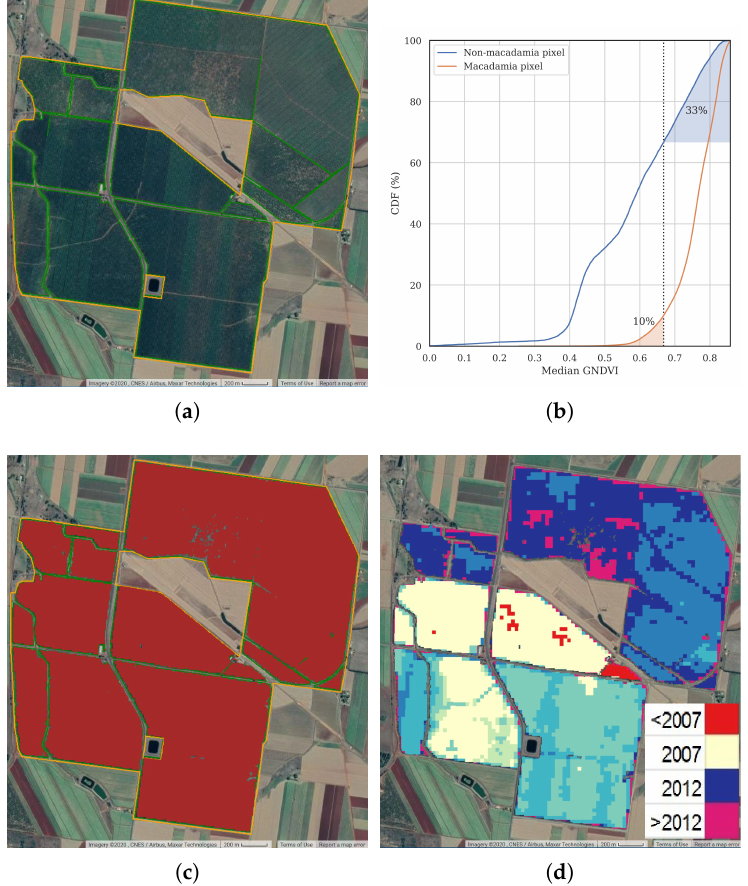
Figure 6. ( a ) Example Bundaberg macadamia orchard, with the ATCRRM feature shown in orange, and block boundaries in green. ( b ) Cumulative distribution plot showing proportion of pixels inside and outside macadamia areas as a function of GNDVI median . ( c ) The productive area mask for the Bundaberg example, and ( d ) per-pixel planting year